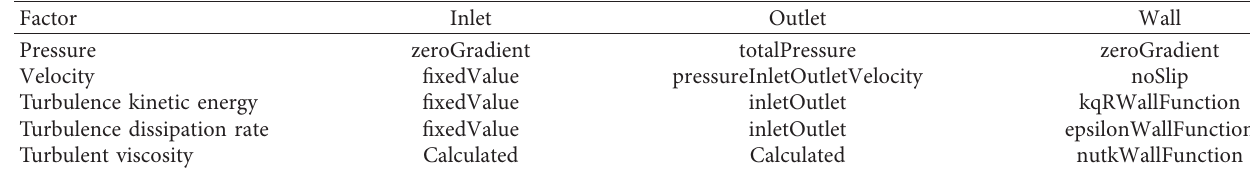
Table 2: Boundary condition types of target CFD models.